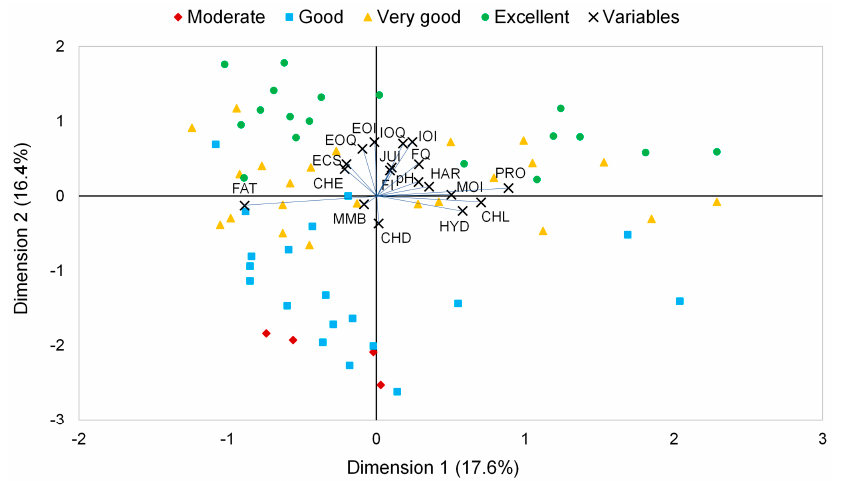
Figure 1. Scatter plot that shows the first plane result, which together covers 34% of the total variance. Variables are shown by lines, where MOI: moisture (g/100 g Dry Matter (DM)), PRO: protein (g/100 g DM), FAT: fat (g/100 g DM), CHL: chlorides (g NaCl/100 g DM), HYD: hydroxyproline (g/100 g DM), CHD: carbohydrates (glucose/100 g DM), EOQ: external odor quality, EOI: external odor intensity, ECS: ease of casing separation, MMB: meat mass binding, IOQ: internal odor quality, IOI: internal odor intensity, HAR: hardness, CHE: chewiness, JUI: juiciness, FQ: flavor quality and FI: flavor